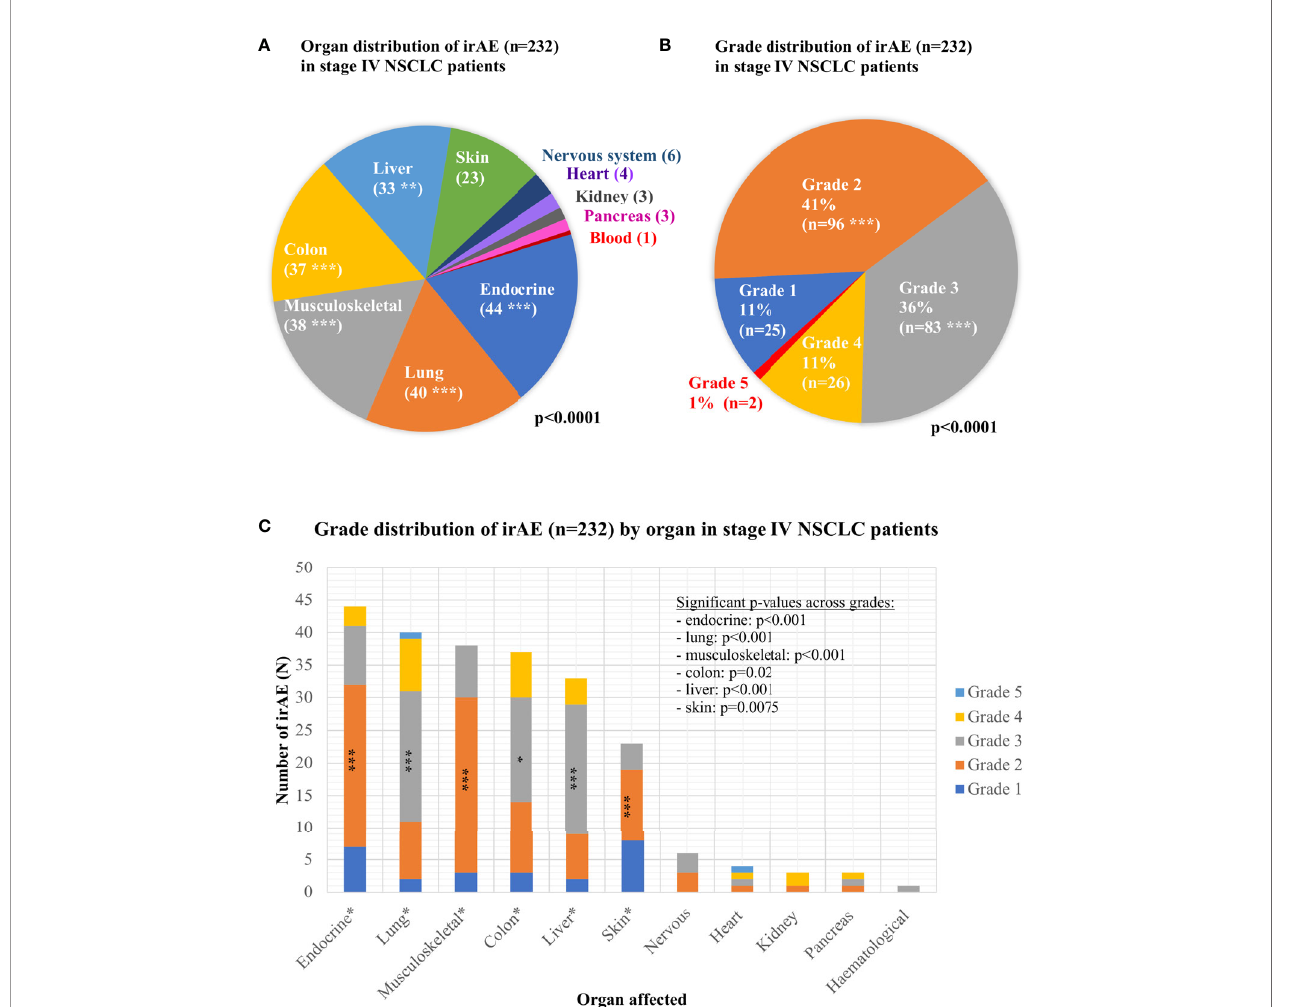
FIGURE 2 | Organ and grade distribution of immune-related adverse events in immunotherapy-treated non-small-cell lung cancer patients. (A) Organ distribution of the 232 immune-related adverse events (irAEs) observed in stage IV non-small-cell lung cancer (NSCLC) patients (p < 0.0001 with a chi-square test across the various affected organs; detailed results are shown in Table 2 ; ***p < 0.001, **p < 0.01, *p < 0.05). (B) Grade distribution of the 232 irAEs observed in stage IV NSCLC patients (p < 0.0001 with a chi-square test across grades, grades with signi fi cantly increased frequency are marked with asterisks). (C) Grade distribution of the irAEs observed in each organ for stage IV NSCLC patients. For each organ, the p-value was calculated with a chi-square test of the observed frequencies for each grade against the even distribution (endocrinological: 44 irAEs overall, grade 1:7, grade 2:25, grade 3:9, grade 4:3, p < 0.001; lungs: 40 irAEs overall,